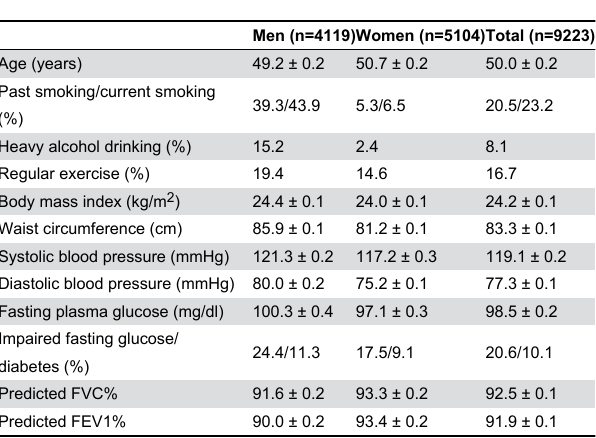
Table 1. Clinical characteristics of study population aged 19 years and older.